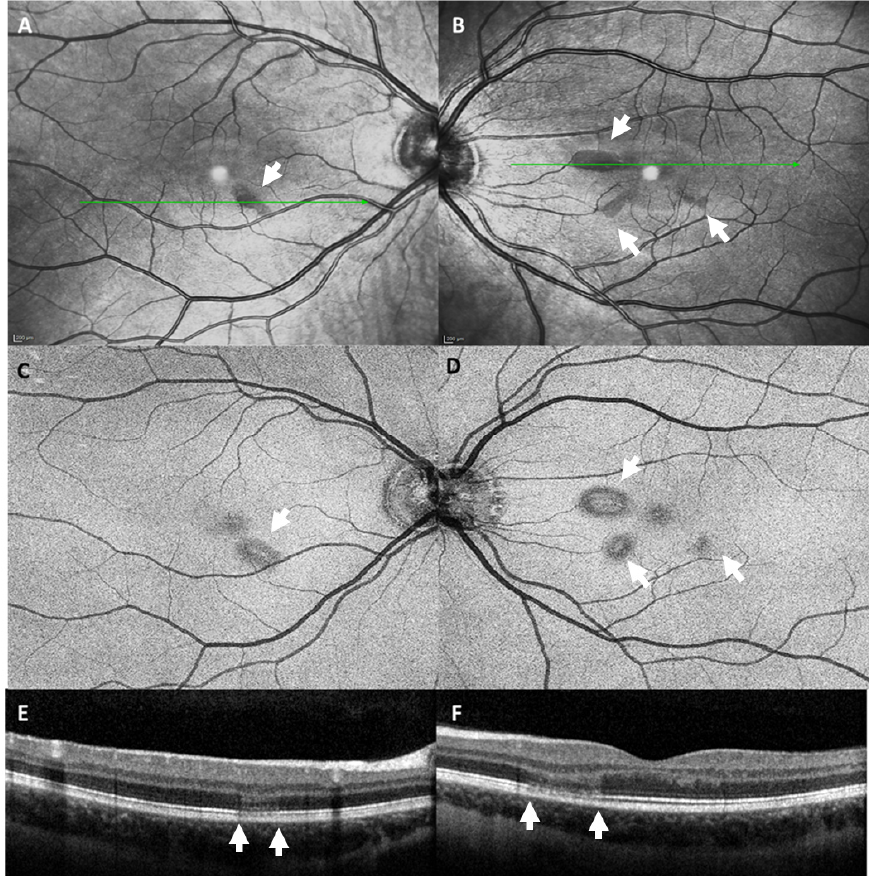
Figure 6. Infrared images ( A , B ) and en-face optical coherence tomography of the level of the ellip- soid zone ( C , D ) showed parafoveal lesions (white arrow) in both eyes. Optical coherence tomogra- phy of the macula ( E , F ) revealed subtle alterations of the outer retinal layers (area between the white arrows) in both eyes.